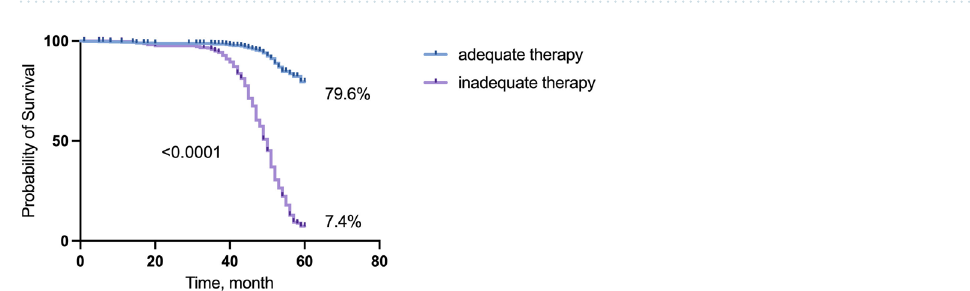
Figure 6. Variants of molecular subtype conversions in breast cancer patients from group 1 and 2 with different NAC responses.